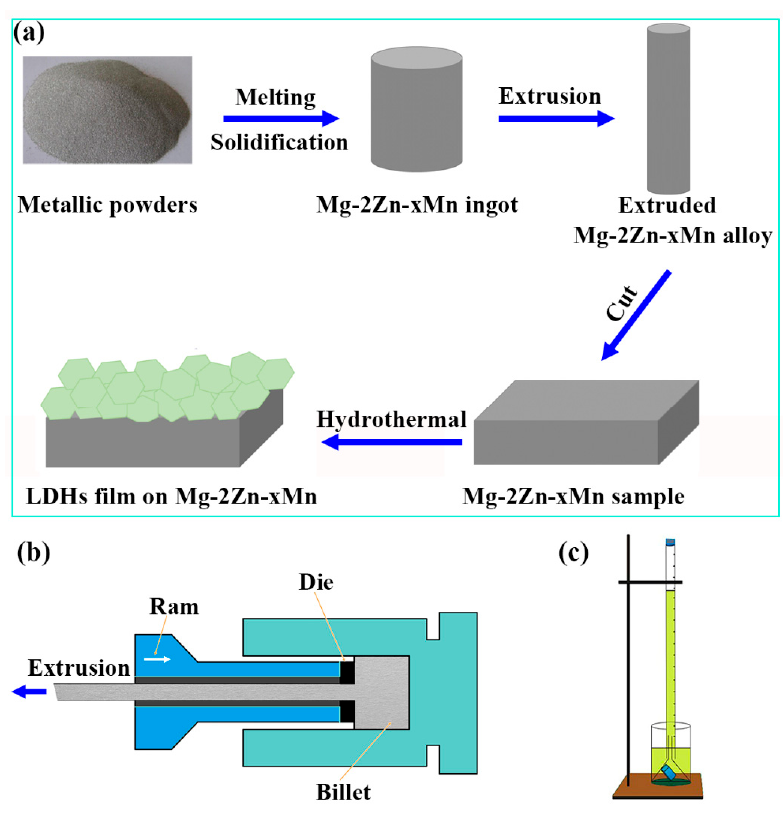
Figure 1. ( a ) Schematic diagram of preparation process of LDHs film on magnesium alloy. ( b ) Schematic diagram of the extrusion process. ( c ) Schematic diagram of the device to evaluate hydrogen evolution.